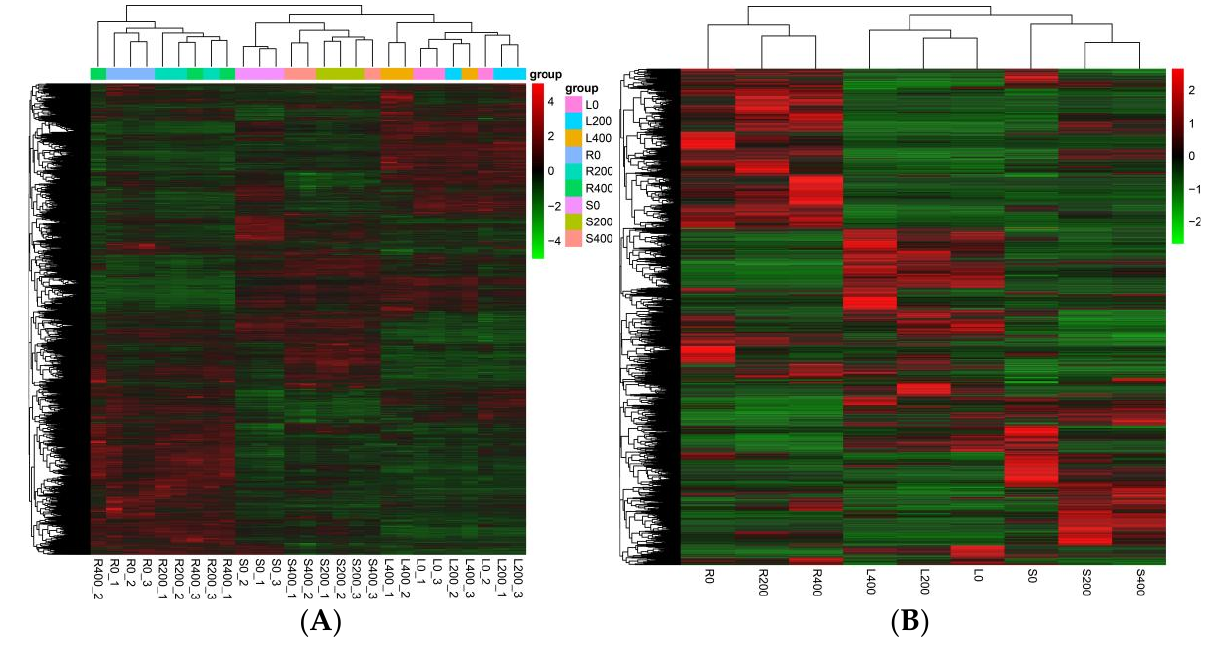
Figure 5. Cluster heat maps of differentially expressed genes. Clustering between ( A ) samples and ( B ) groups.